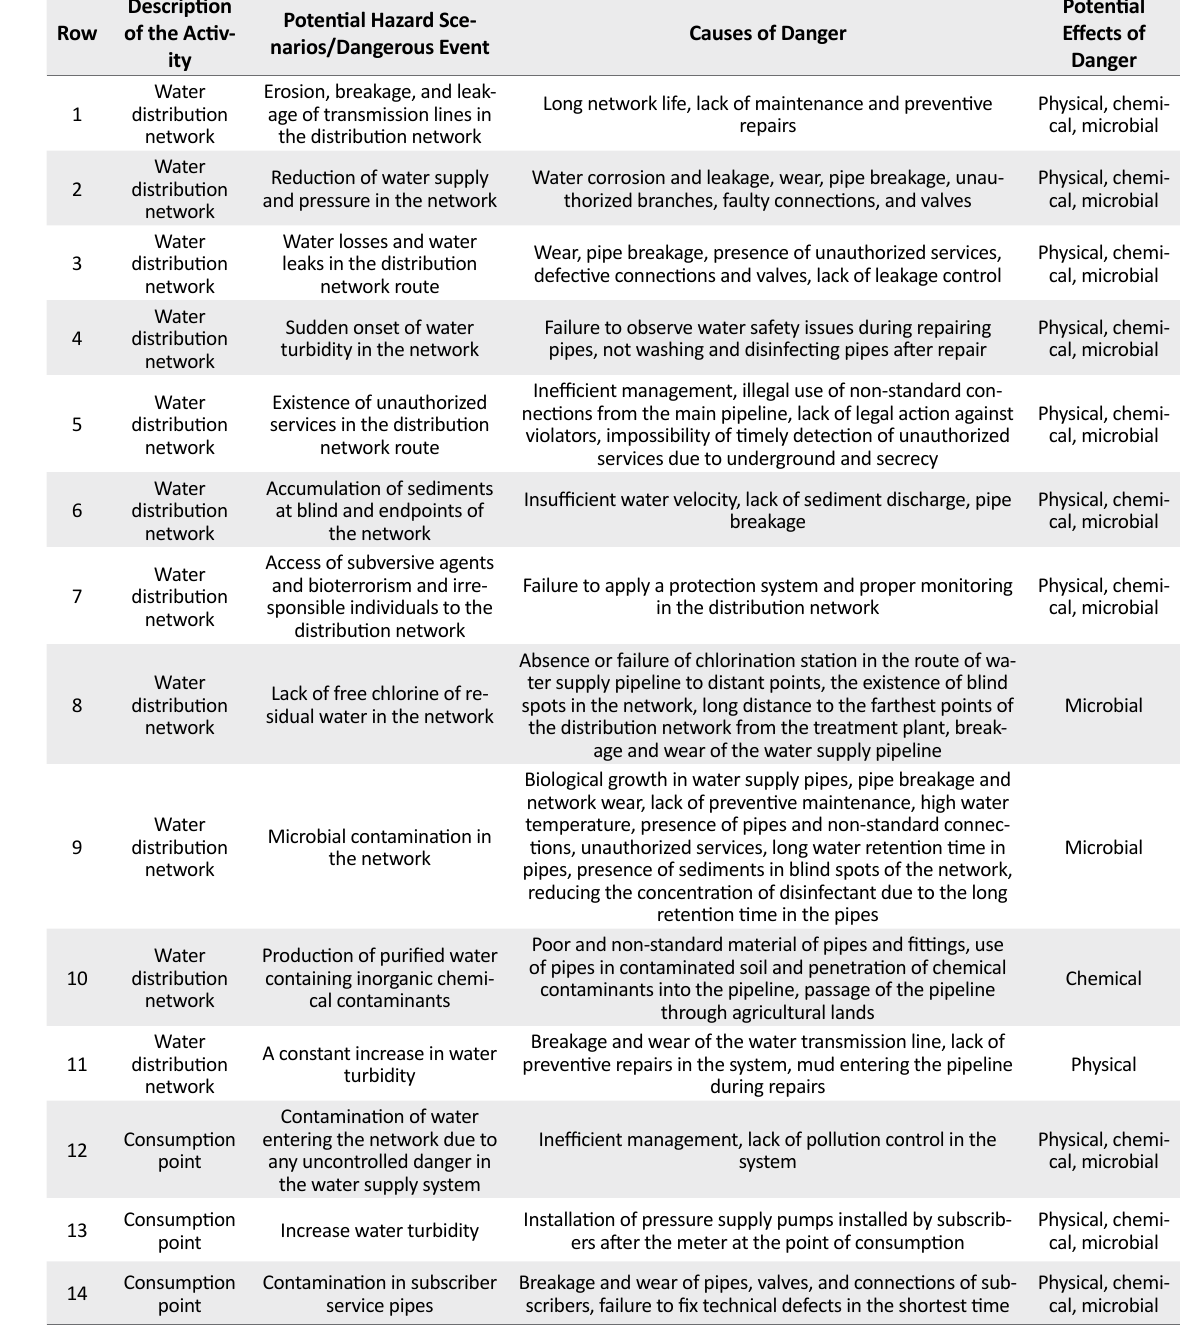
Table 4. Identification of hazardous events in the distribution network and point of consumption